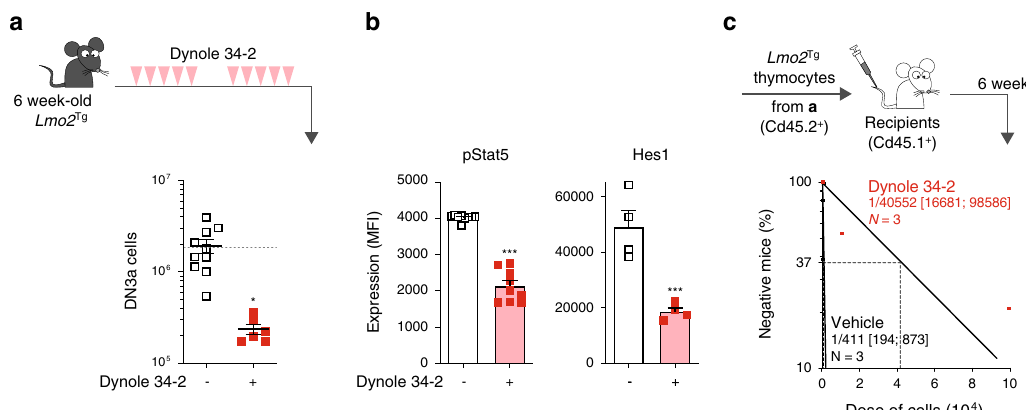
Fig. 3 Inhibition of receptor-mediated endocytosis of IL-7R and Notch1 by Dynole 34-2 impairs pre-LSC self-renewal. a Treatment schematic and absolute numbers of DN3a T-cell progenitors in the thymus of 6-week-old Lmo2 Tg mice following treatment with vehicle or Dynole 34-2. Mean ± SEM, Student ’ s t -test; * P < 0.05 compared to vehicle. Each square represents an individual animal. Dashed line indicated the mean absolute number of DN3a thymocytes in wild-type (WT) mice at 6 weeks of age. b Levels of activated Stat5 (pStat5, left) and Hes1 (right) proteins in DN3a cells from Lmo2 Tg mice treated with vehicle or Dynole 34-2, assessed by fl ow cytometry. Mean ± SD of n = 3 individual mice are shown. Student ’ s t -test *** P < 0.001 compared to vehicle. c Pre-LSC frequency within the DN3a thymocyte population of Lmo2 Tg mice treated with vehicle or Dynole 34-2 assessed by limiting dilution assays. Mice were scored positive when T-cell lineage reconstitution was more than 1%, as previously described 13 . Pre-LSC frequencies and [95% con fi dence intervals] are shown and calculated from three individual